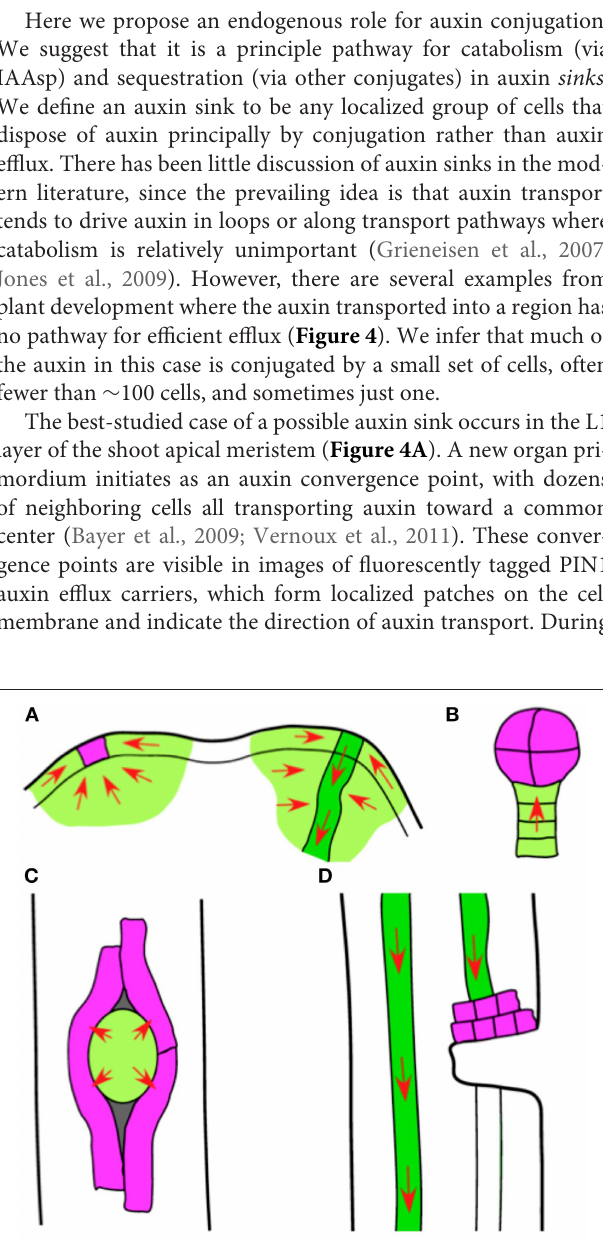
FIGURE 4 | Sketches of putative auxin sinks. In the development of Arabidopsis and other seed plants, there are many cases where auxin transport (red arrows) drives an accumulation of auxin. (A) Two stages in the development of an organ primordium in the shoot apical meristem (SAM). The primordium eventually develops a provascular strand (right, dark green) that exports auxin from the SAM, supplied with auxin from many adjacent cells (light green). There is an earlier stage in primordium development (left) where all auxin transport converges on just one or a few cells (purple). (B) An early-stage embryo. Auxin is transported through the suspensor (light green) into the embryo (purple). (C) Emergence of a lateral root primordium. As the primordium (light green) grows through the root cortex and epidermis, only those outer-root cells in direct contact with the primordium (purple) show auxin-mediated gene activation. (D) A wounded stem. If the wound severs a vascular bundle (dark green), auxin transported through the bundle accumulates in a thin layer of cells immediately above the wound